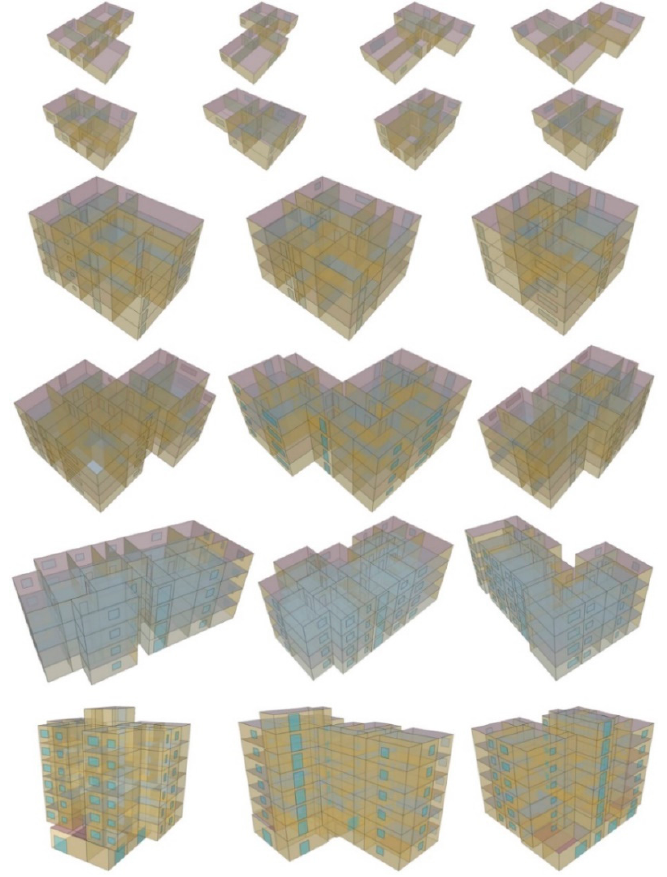
Figure 10. Examples of the generated buildings ranging from the single ‐ storey family house to multi ‐ storey mixed ‐ use apartment buildings. multi-storey mixed-use apartment